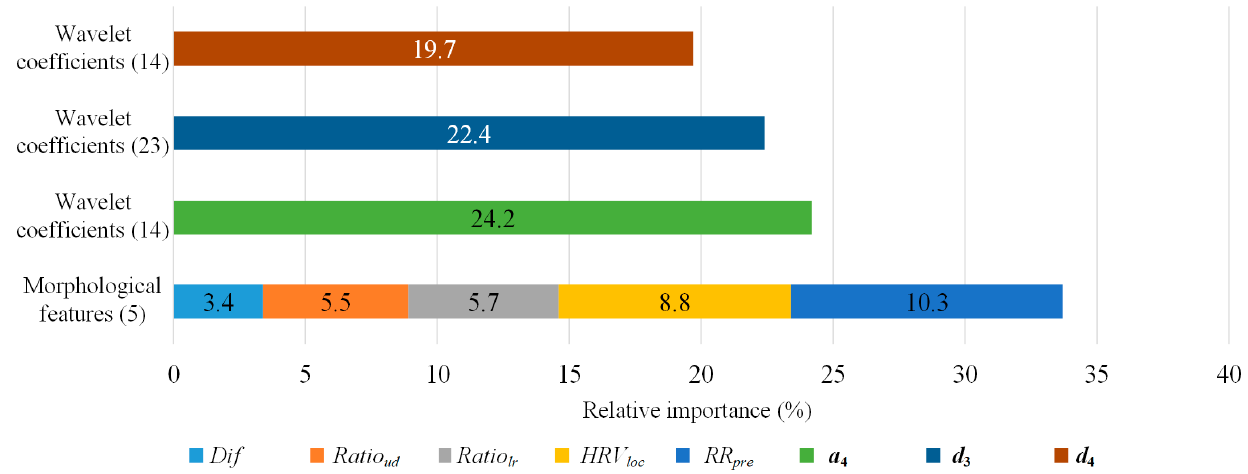
Figure 4. The relative importance of the features on the MITDB. The number in the brackets is the dimension of features.